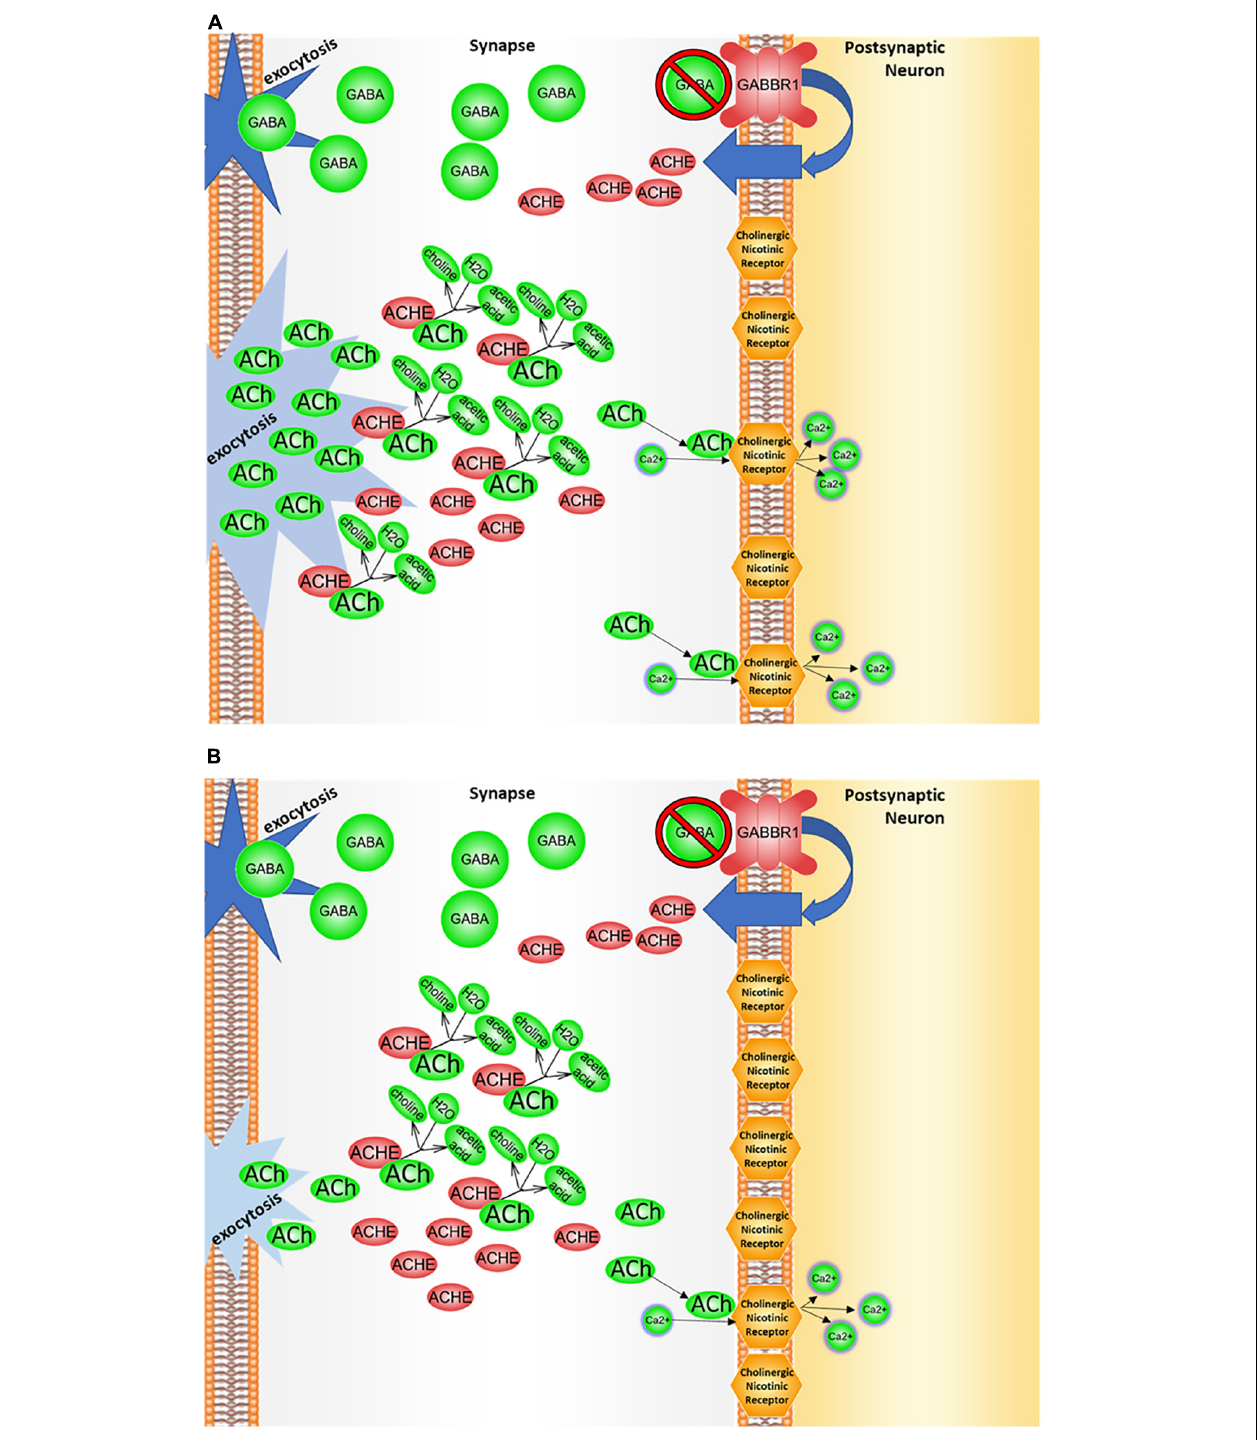
FIGURE 6 | GABBR1 /ACHE regulation. (A) In the presence of GABBR1 variant. The autism-associated GABBR1 variant may affect levels of acetylcholinesterase (ACHE) in the synaptic cleft by decreasing either total levels of GABBR1 expression and/or function of its gene product, the GABA B1 receptor. Under this condition, the cascade that normally downregulates acetylcholinesterase expression may be suppressed. Because of that, larger amounts of the enzyme are produced, and the acetylcholine degrades at an elevated rate, resulting in less acetylcholine in the synaptic cleft and less signaling through the cholinergic receptor. (B) In the presence of GABBR1 variant and a dietary choline deficiency. When choline levels are deficient, less acetylcholine (ACh) is available in the neurons for signaling, and a decrease in cholinergic binding/signaling attributed to GABBR1 variant would be exacerbated.